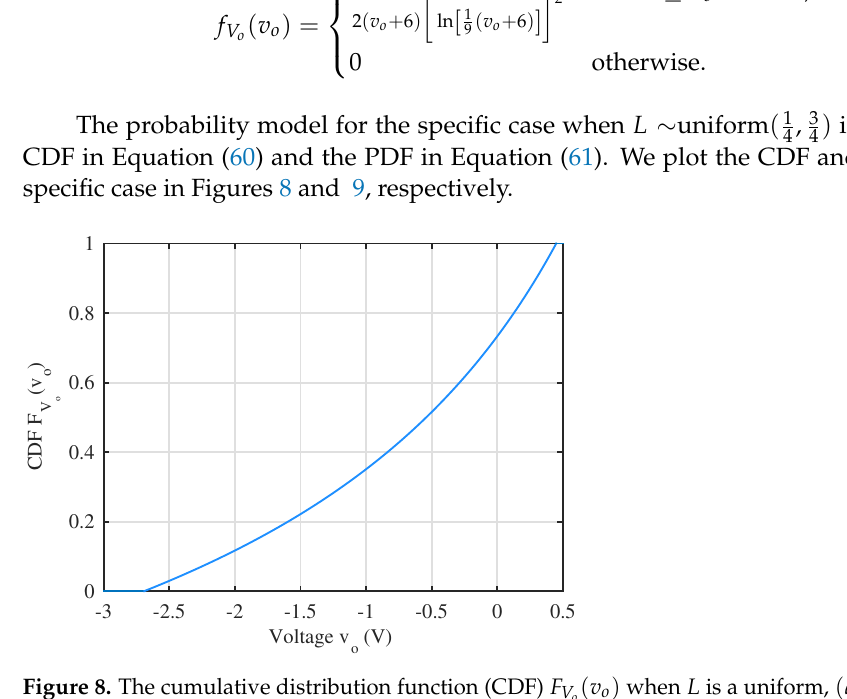
Figure 8. The cumulative distribution function (CDF) F V random variable, such that a = 1